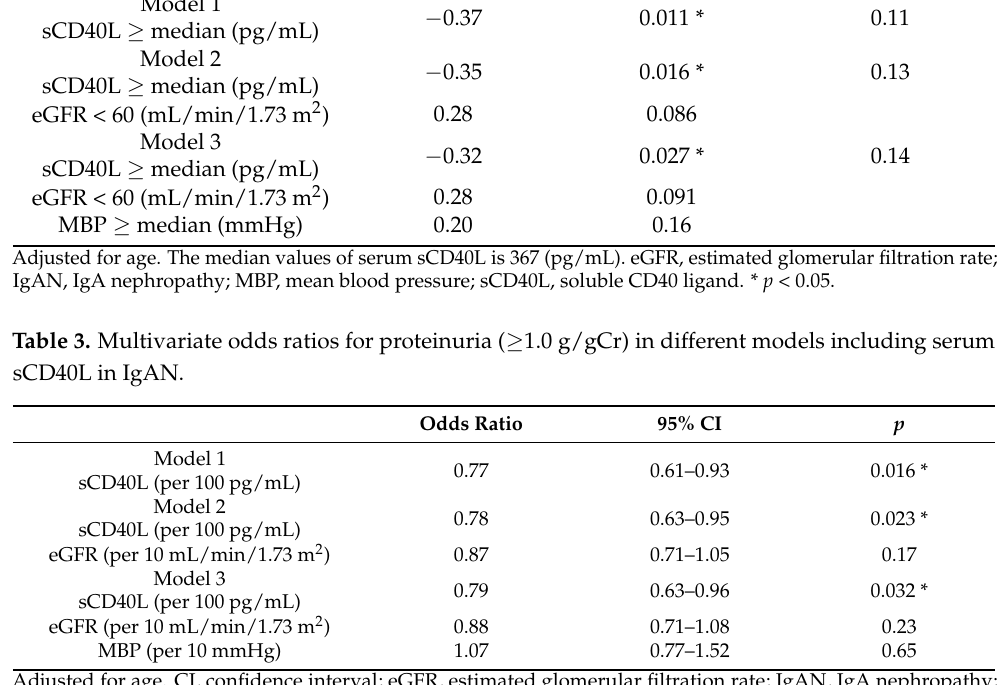
Table 2. Multivariate-adjusted regression analysis of predictors of proteinuria in different models including serum sCD40L in IgAN. β p Model R 2 Model 1 − 0.37 sCD40L ≥ median (pg/mL)